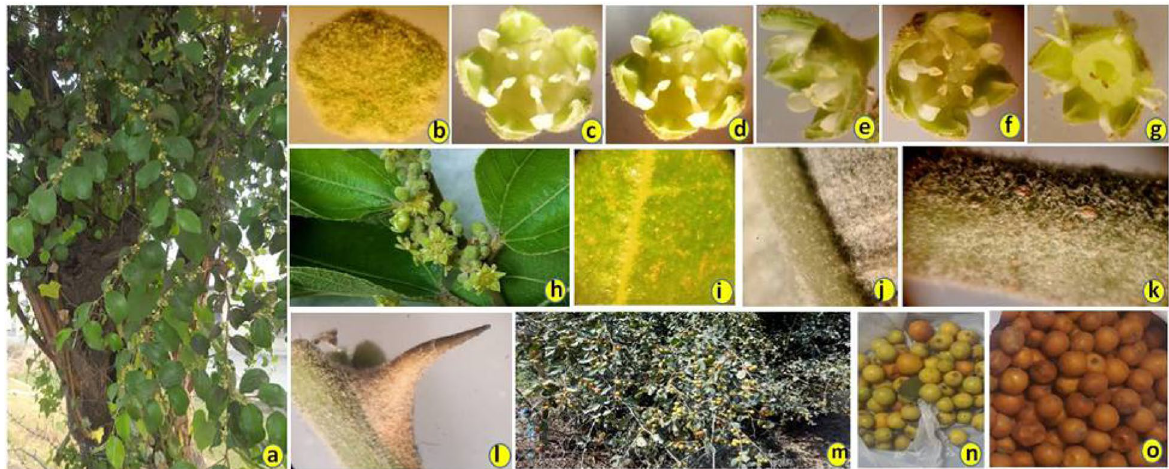
Fig. 1 Morphological features of Z. mauritiana and Z. nummularia . a ) Mature plant of Z. mauritiana . b ) Flower bud of Z. mauritiana photographed with stereomicroscope. c – g ) Stereomicroscopic photographs of flower showing anthers and stigma. h ) A flowering branch. i ) Abaxial